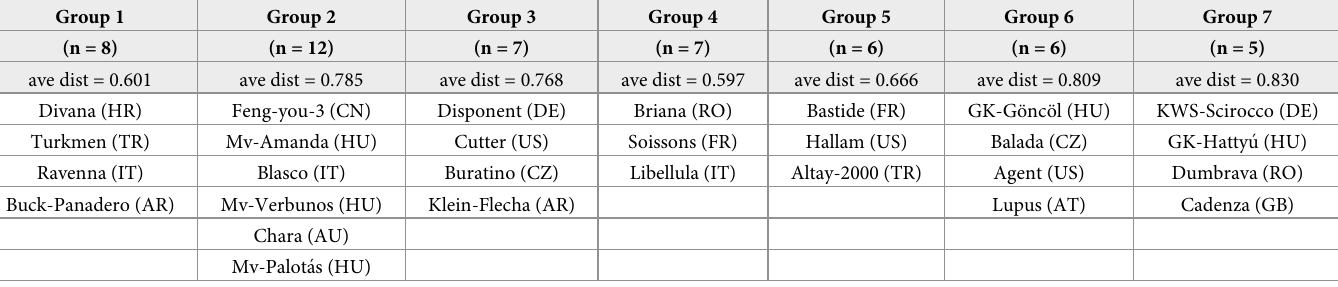
Table 2. The most characteristic members of the 7 phenotypic wheat groups identified via K-means clustering and discriminant analyses based on their grain yield profiles. Group 1 Group